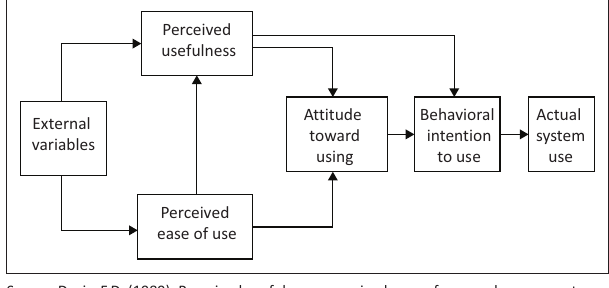
FIGURE 2: Technology acceptance